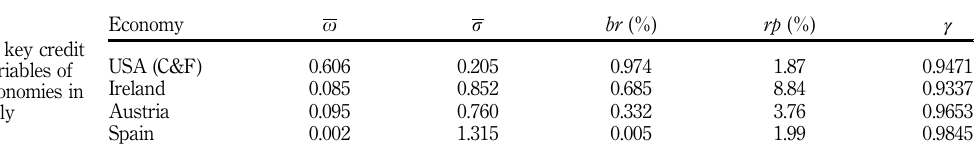
Table III. Calibration key credit channel variables of the four economies in the quarterly